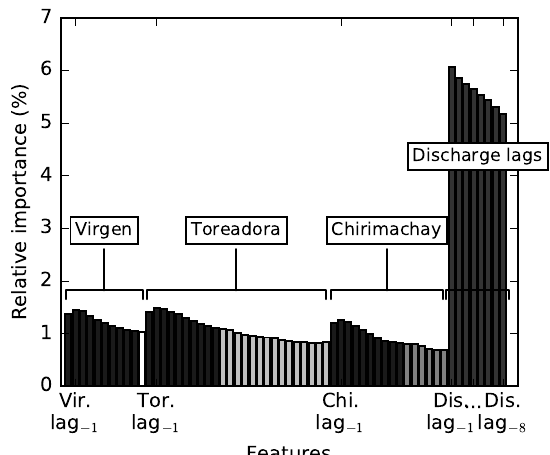
Figure 6. Feature relative importance of the 4-h discharge forecasting model B. Darkest bars indicate the features selected for a reduced version of the input (model